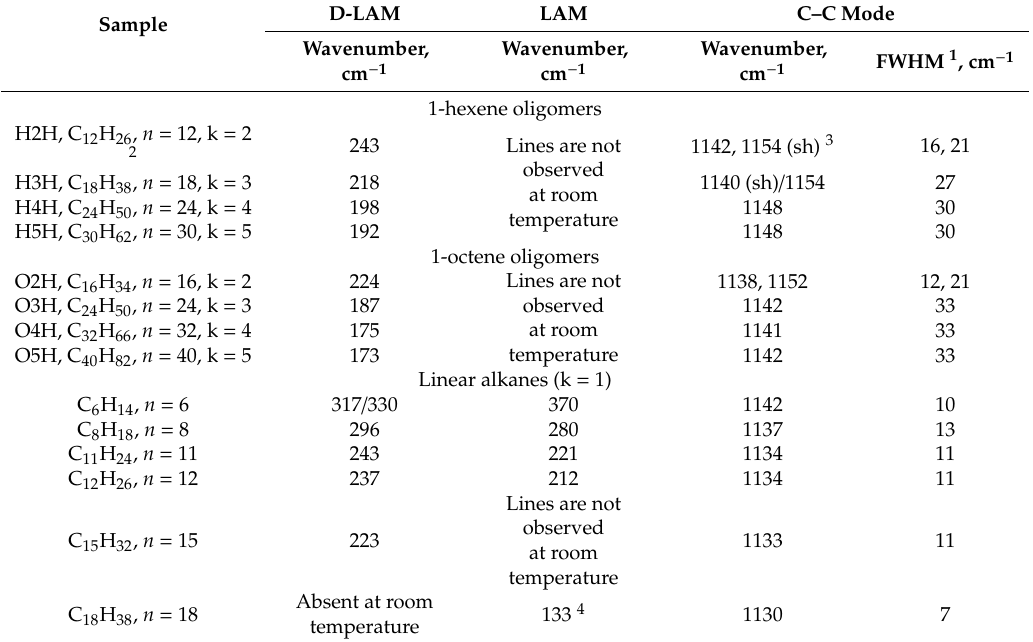
Table 1. The observed wavenumbers of some Raman-active bands of the hydrogenated 1-hexene and 1-octene oligomers and linear alkanes with n = 6, 8, 12, 16, and 18 at room temperature. D-LAM Sample